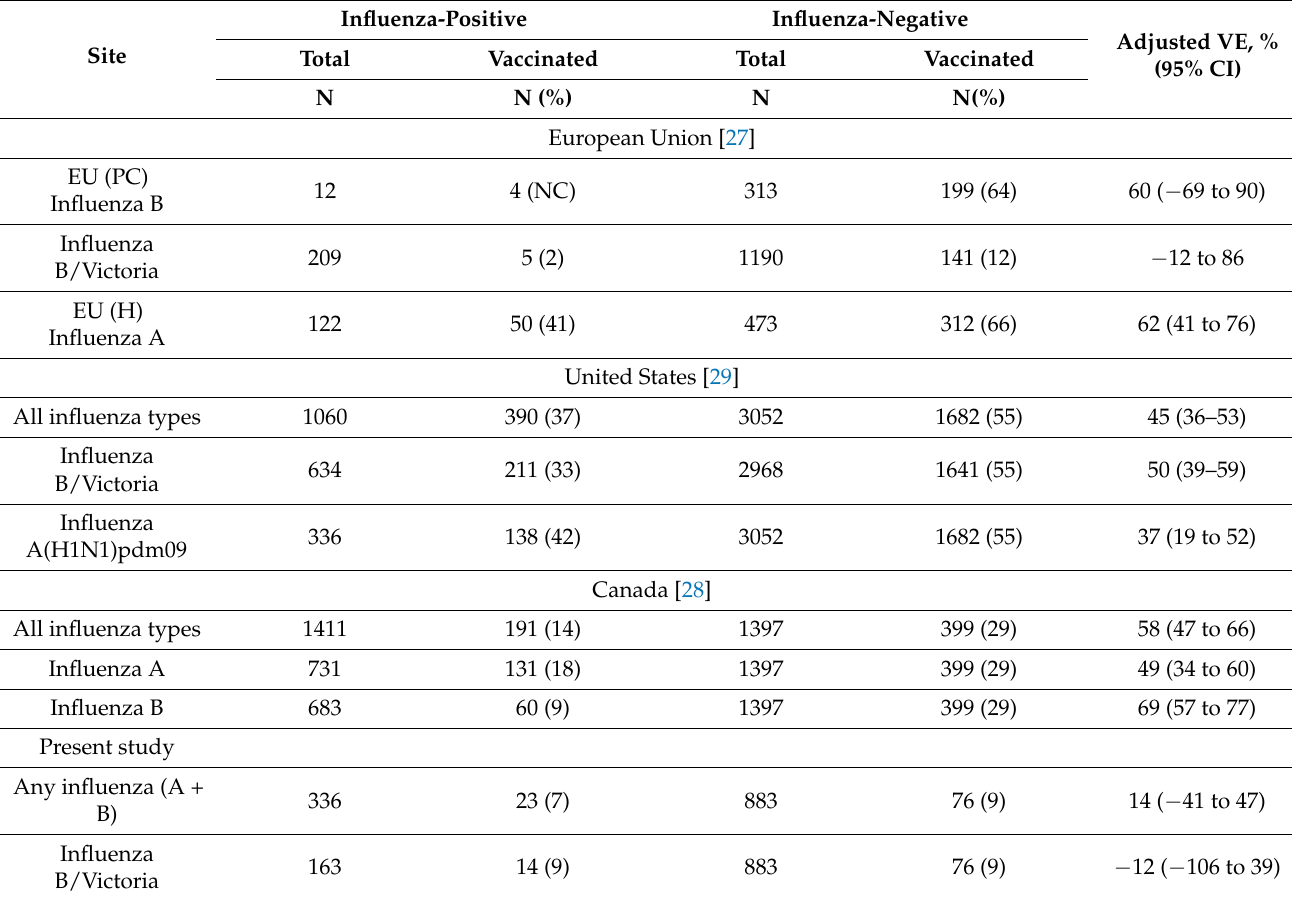
Table 3. Depiction of the comparative vaccine effectiveness against any influenza (A + B) and influenza B in the 2019-2020 season reported from other geographic